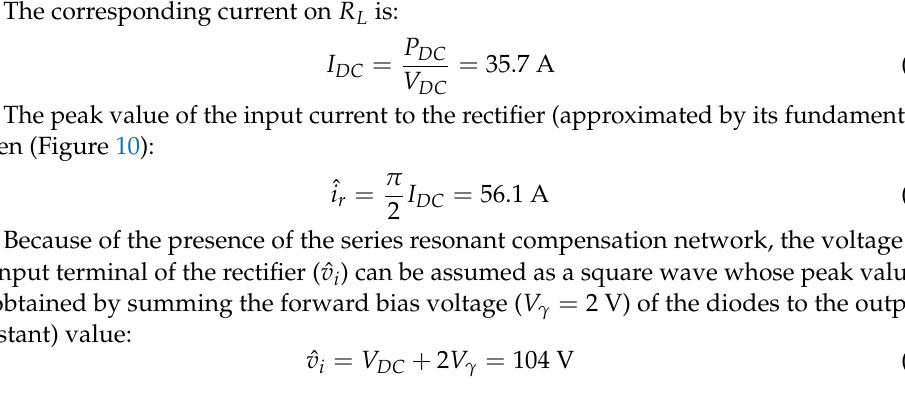
Figure 10. Equivalent circuit of the receiving section: the DC/DC step-down converter and the battery pack are modeled as a resistive load R L with a rated power of 3.57